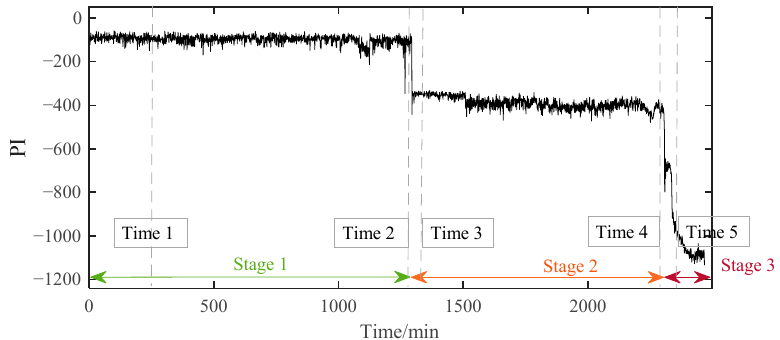
Figure 9. The PI results of B1 based on SC-RMI and Student’s t-HMM. To verify the above assessment results, five special time points around the stage transition points were chosen for further explanation. Their time plots and envelope spectrum plots are displayed in Figures 10 and 11. At Time 1 and Time 2, no obvious shock signal could be found in the vibration signal, and the amplitudes at the rotating frequency and ball pass inner race frequency (BPIF) could not be observed. At Time 3 and Time 4, the amplitudes of vibration were greater than those at Time 1 and Time 2, and the amplitudes at rotating frequency and its harmonic frequency increased. However, the amplitudes at BPIF were still not obvious. At Time 5, obvious periodic shock could be observed in the time plot, and the amplitudes at the rotating frequency and BPIF were quite obvious. The envelope spectrum covered the characteristics of the bearing inner race fault signal, which means that obvious inner ring fault had occurred in the bearing. B1 did eventually fail for the inner race fault, which was manifested by inner ring surface peeling and serious reduction in surface roughness, as shown in Figure 12, in which the fault position was located in the elliptical red frame. Therefore, PI obtained by the proposed method can effectively evaluate the performance degradation process of B1.